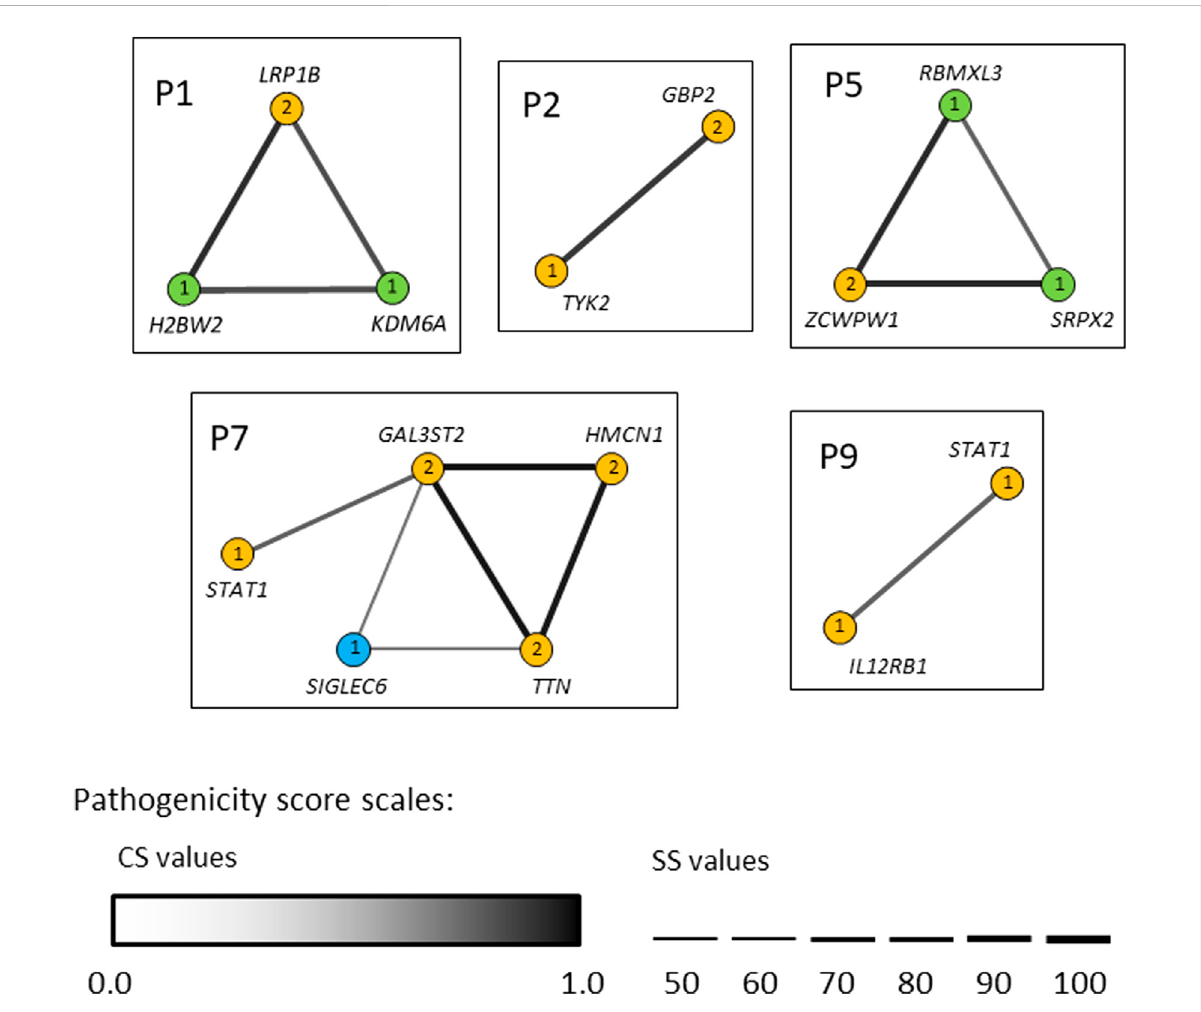
FIGURE 6 Genenetworksshowingtheepistaticinteractionsbetweenthegenesinwhichrarevariantshavebeenidenti fi ed.Nodesareindividualgenesand edges represent pair-wise interactions between genes/variants. Numbers inside the nodes denote number of variants. Yellow, blue and light-green nodes represent heterozygous, homozygous and hemizygous variants, respectively. Edge color intensity is proportional to the pathogenicity classi fi cation score (CS), whereas edge thickness is proportional to the pathogenicity support score (SS) for a combination of variants. In case two variants within one gene (i.e., compound heterozygotes), the highest pathogenicity scores computed for variant combinations are depicted. Only disease-causing variant combinations/networks (cutoff > 0.532 for CS and ≥ 50% for SS) are